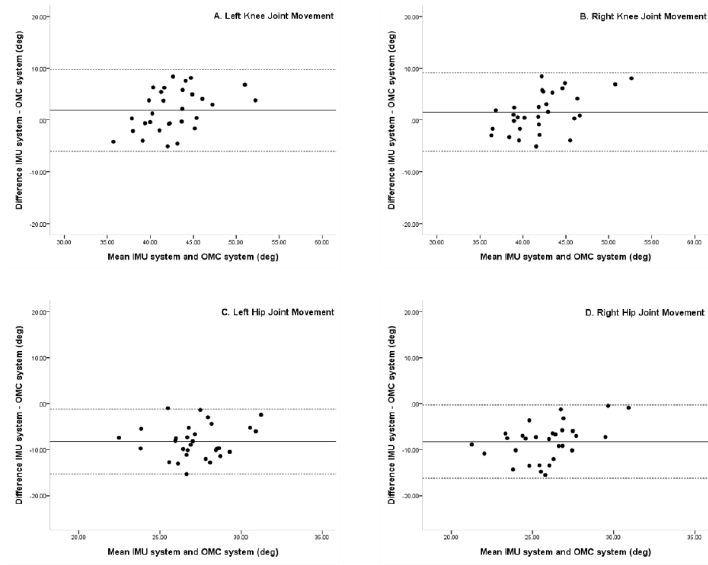
Figure 4. Bland–Altman plots comparing IMU system (LEGSys + ) and OMC system (Qualisys) results for peak to peak ( A ) Left knee joint degree, ( B ) Right knee joint degree, ( C ) Left hip joint degree, and ( D ) Right hip joint degree. Bias (solid line) and limits of agreement (dashed line) are shown for each variable. The mean score is plotted on the x-axis, and the difference between the two devices is plotted on the y-axis (mean difference ± 1.96 SD).